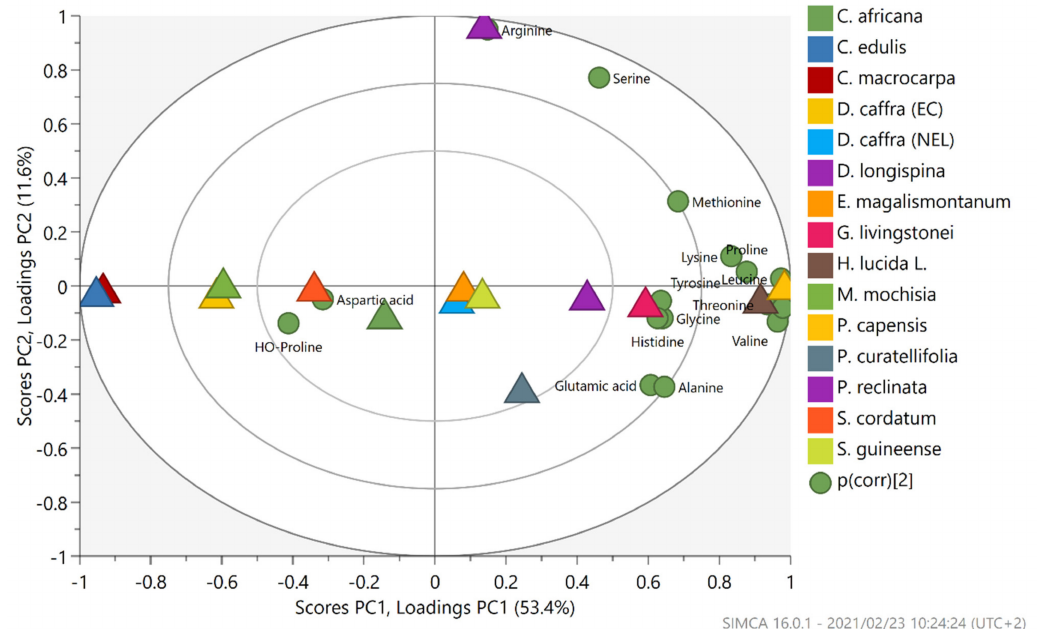
Figure 2. Principal Component Analysis (PCA) multivariate projection score and loading scatter plots of amino acids composition in wild indigenous fruits of Southern Africa. Fruit samples color coded as: Cordyla africana (dark green), Carpobrotus edulis (blue), Carissa macrocarpa (deep red), Dovyalis caffra -EC (mustard), Dovyalis caffra -NEL (light blue), Dovyalis longispina (purple), Englerophytum magalismontanum (light orange), Garcinia livingstonei (Red), Halleria lucida (brown), Manilkara mochisia (green), Pappea capensis (yellow), Parinari curatellifolia (dark blue), Phoenix reclinata (Orchid purple), Syzygium cordatum (orange), and Syzygium guineense (light